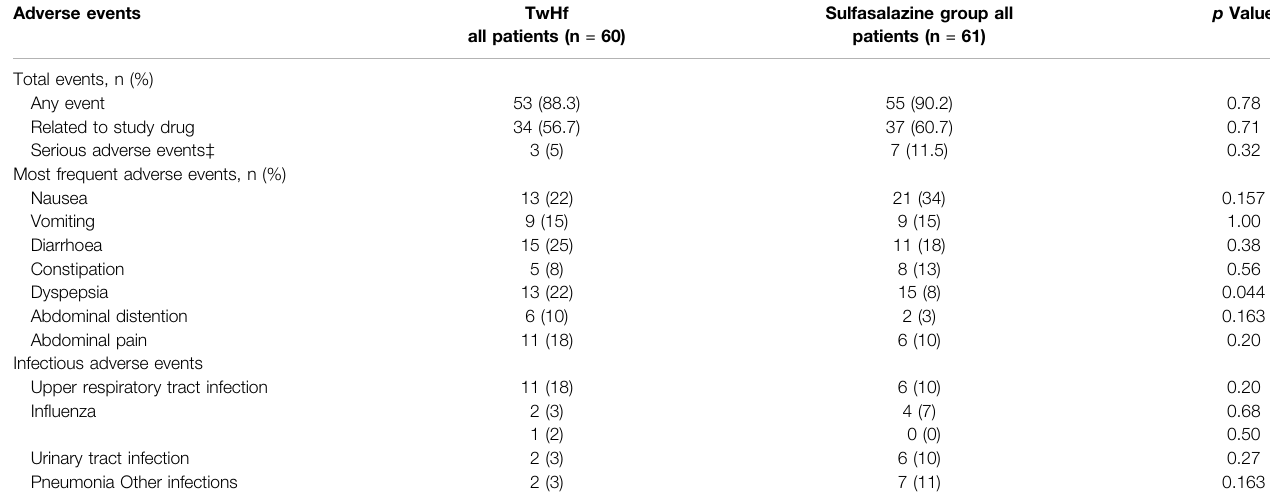
TABLE 2 | Comparison of adverse reaction events between TwHf and sulfasalazine in the treatment of RA (Goldbach-Mansky et al., 2009), Copyright 2009, ACP. Adverse